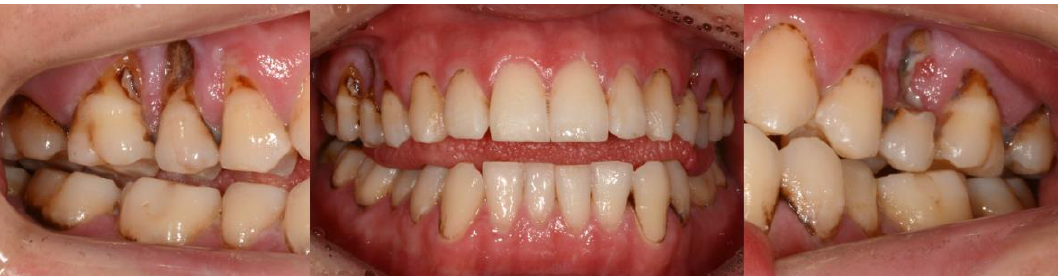
Figure 1. Gingival injury from self-injurious behavior.